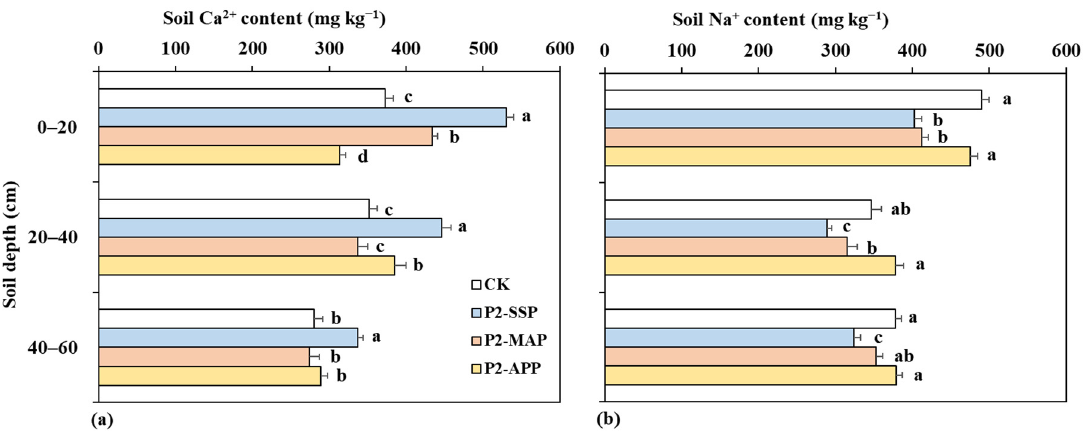
Figure 3. Soil water soluble Ca 2+ ( a ) and Na + ( b ) after wheat harvest in 2019 as effected by three P sources under the P2 treatment (26 kg P ha − 1 ). Horizontal bars represent means + SE ( n = 4). Different letters above bars denote significant differences among treatments at a specific soil layer ( p < 0.05). SSP, superphosphate; MAP, monoammonium phosphate; APP, ammonium